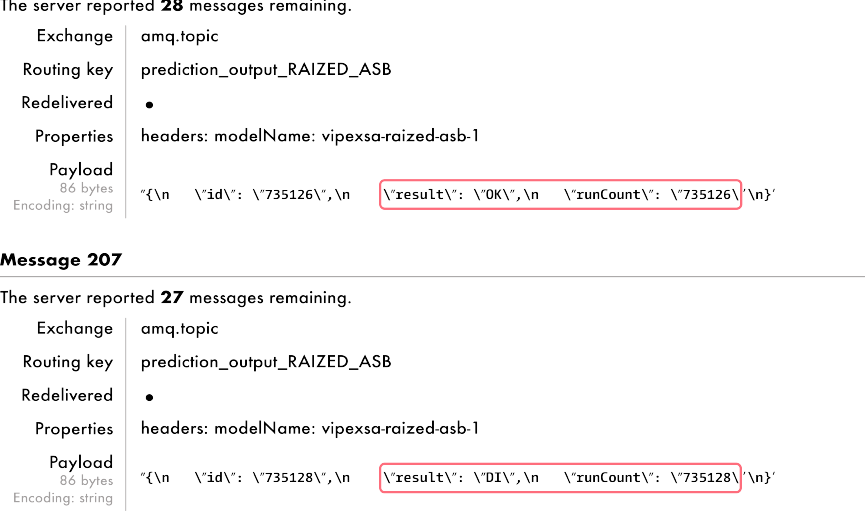
Figure 7. Messages received with the